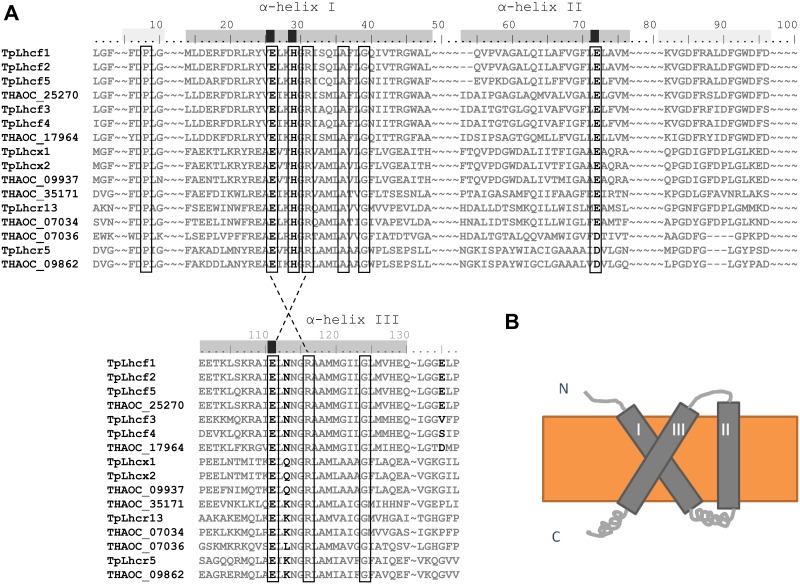
A, Representative sequence alignment of predicted LHCs from Thalassiosira oceanica (THAOC, CCMP 1005) and T. pseudonana (Tp, CCMP 1335): boxes indicate conserved residues; dotted lines show linkage between helix I and III; bold residues are predicted binding sites for Chl molecules. B, Cartoon of the predicted general LHC structure (grey) comprised of three membrane spanning helices within the thylakoid membrane (orange) and the lumenal N-terminus and stromal C-terminus [80].